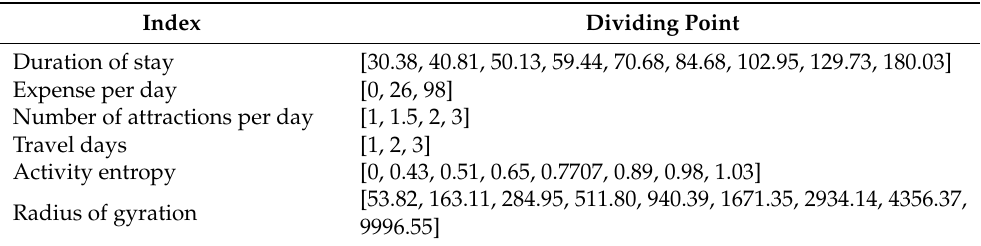
Table A1. Dividing point of interval bins for different behavioral indicators of tourists.